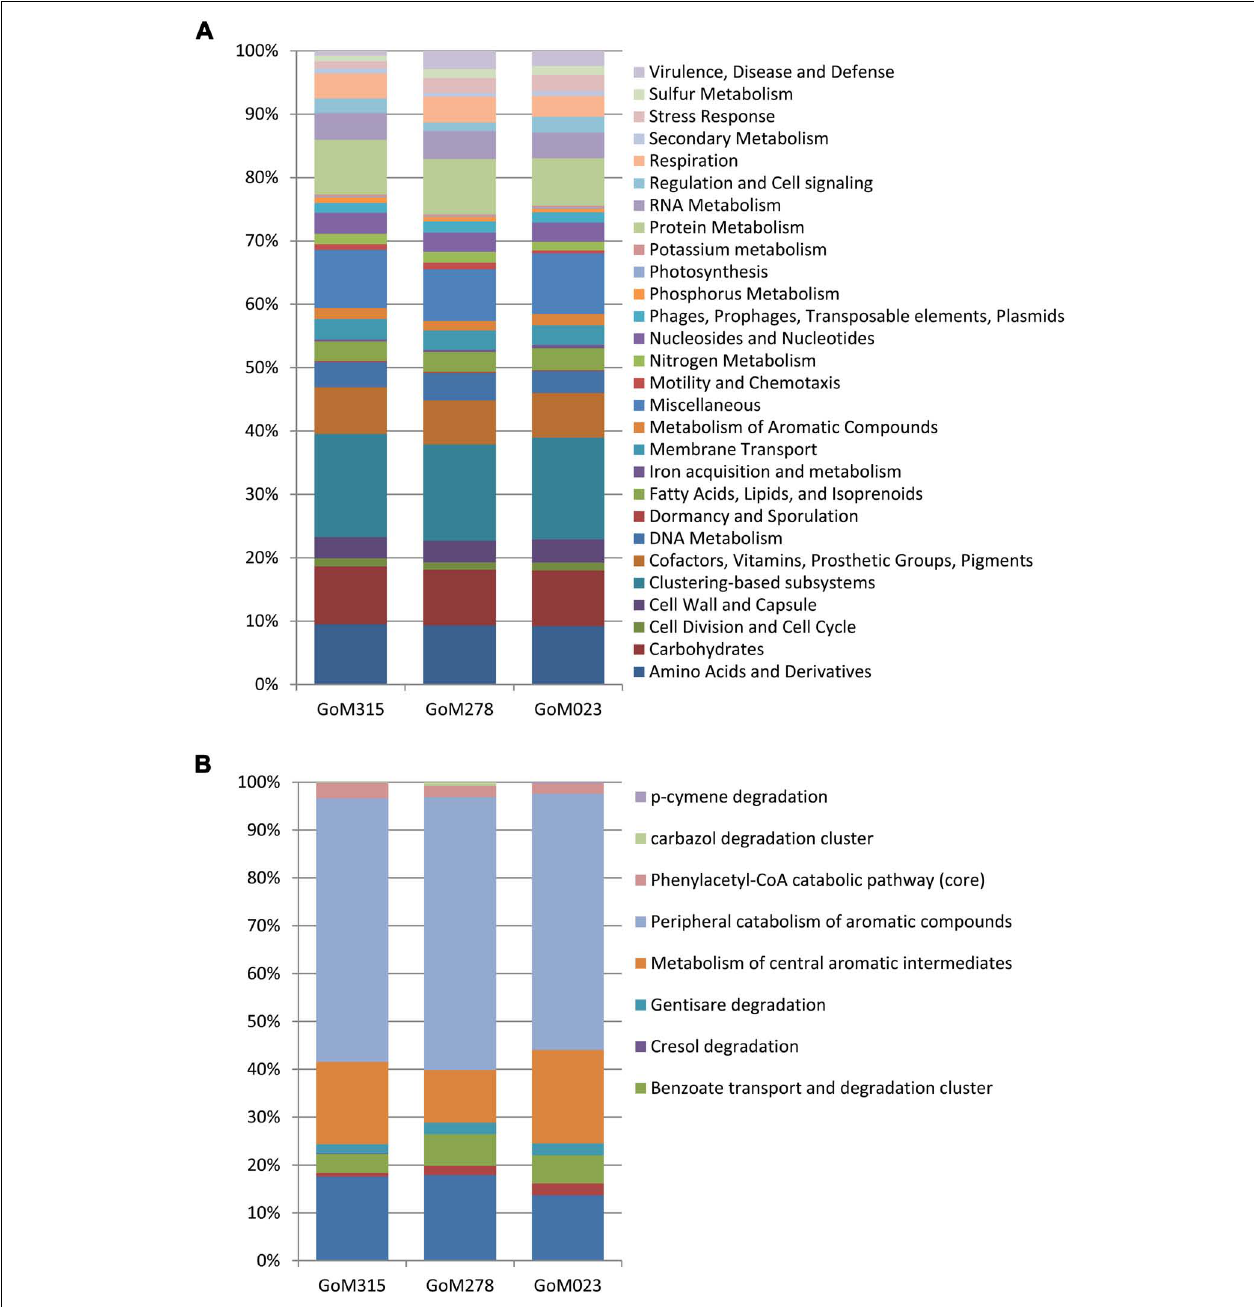
FIGURE 5 | Functional classifications of the metagenomic sequences. (A) Similar functional fingerprints are observed at the broadest subsystem classification. (B) Functional genes associated with the “metabolism of aromatic compounds” reveal a decreased association with “anaerobic degradation in aromatic compounds” in